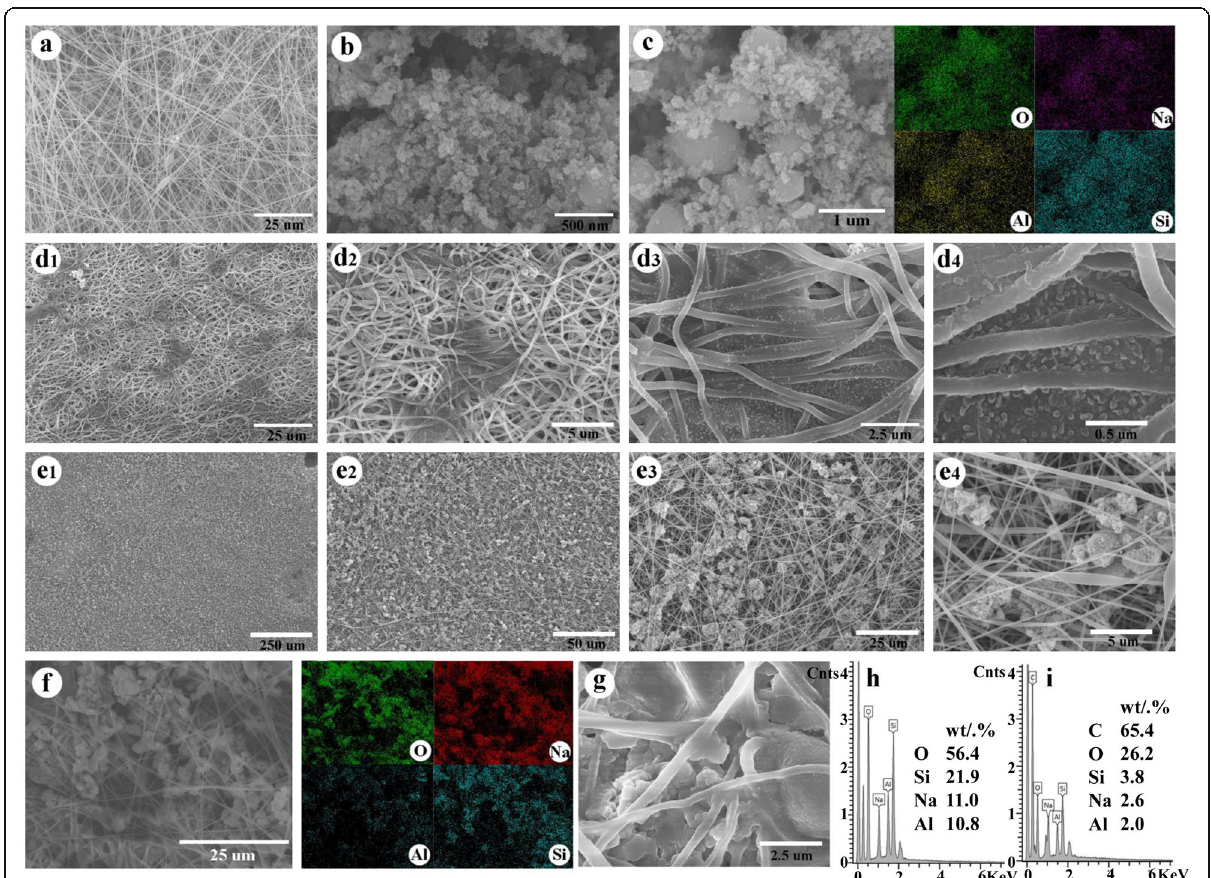
Fig. 2 SEM images of a PVDF-HFP@PAN membrane, b , c MS particles, d PVDF-HFP@PAN after thermal treatment at 100 mL reactor, e PVDF- HFP@PAN after thermal treatment at 25 mL reactor, and f , g the enlarged MS@PVDF-HFP@PAN. h , i EDS results of MS and MS@PVDF-HFP@PAN,